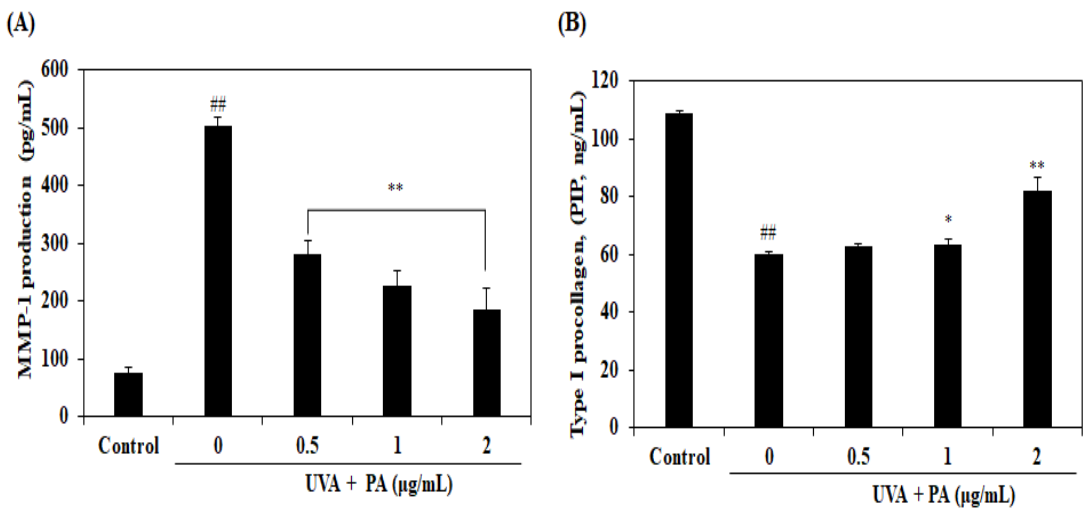
Figure 4. Effects of PA on MMP-1 ( A ) and PIP ( B ) expression in UVA-irradiated HDF cells. The expression levels of MMP-1 and PIP were measured by use of commercial ELISA kits, following the manufacturer’s instructions. The values are expressed as the mean ± SD in triplicate experiments. ## p < 0.01 indicates a significant difference compared to the control group and *p < 0.05 and **p < 0.01 indicate a significant difference compared to the only UVA-irradiated groups.